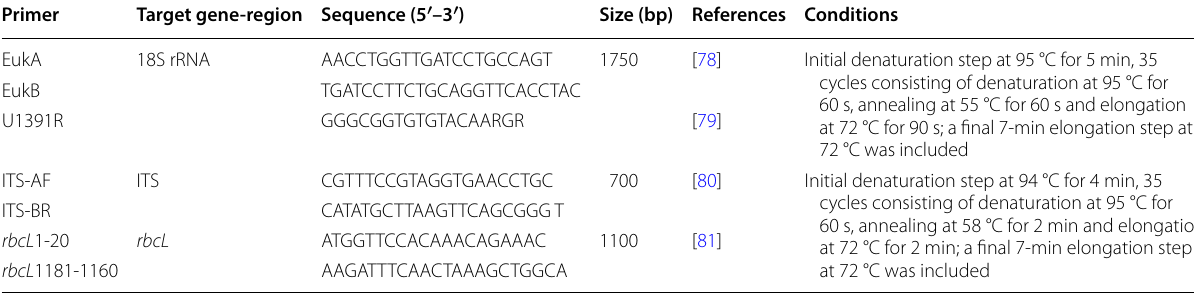
Table 3 PCR primers used in the analyses of green-algae strains isolated from freshwaters of Greece Primer Target gene-region Sequence (5 ′ –3 ′